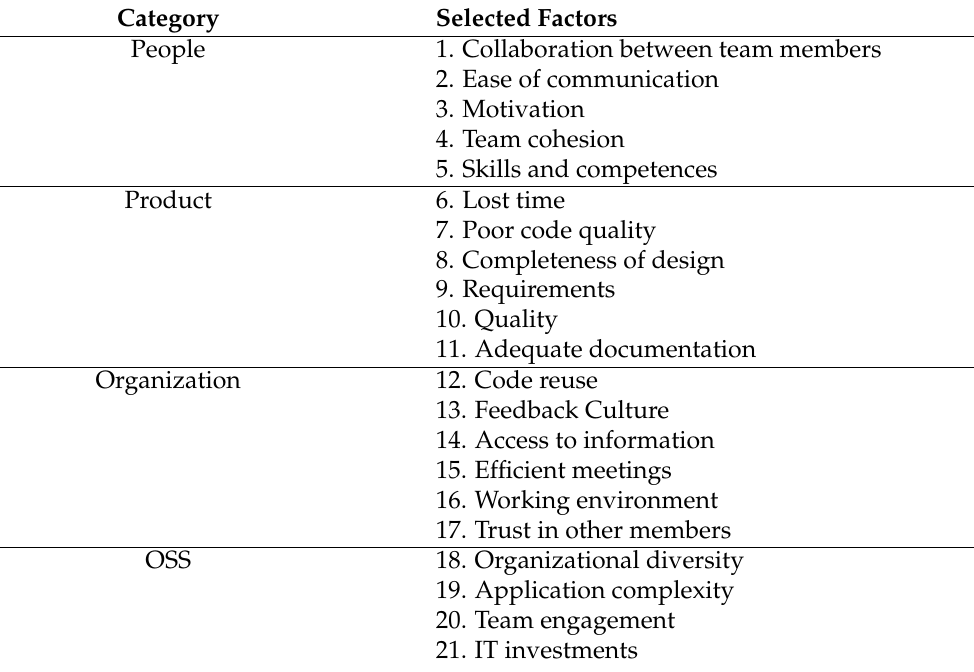
Table 3. Selected factors for the case